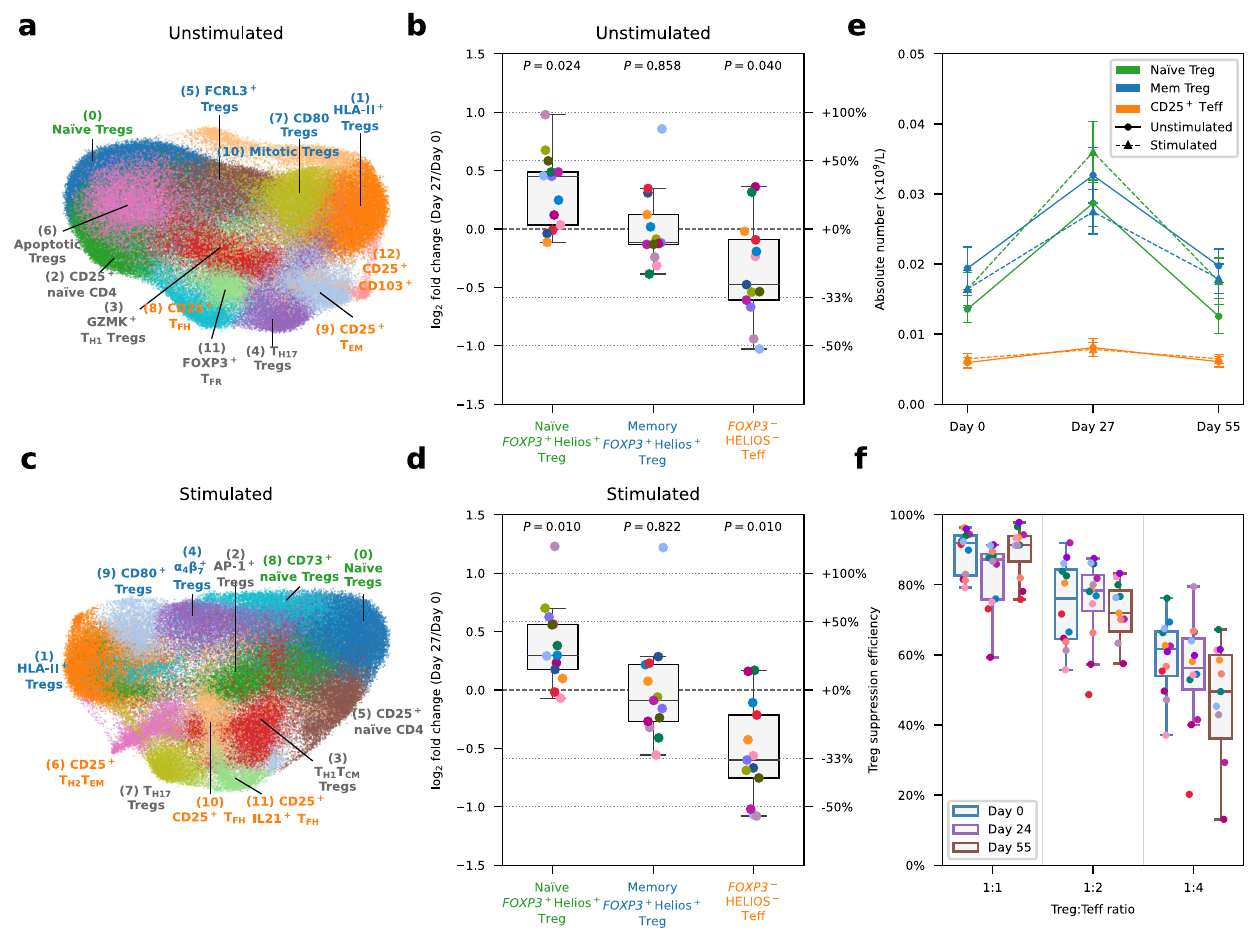
Fig. 2 | Interval low-dose IL-2 immunotherapy selectively expands FOXP3 + HE- LIOS + Tregs.a UMAPplotdepicting n =149,202unstimulatedcellssortedfromthe CD127 low CD25 hi Treg gate. Clusters were manually annotated based on the expression of key mRNA and protein markers. Clusterscorresponding to: (i) naïve Tregs (de fi ned as CD45RA + FOXP3 + HELIOS + ); (ii) memory Tregs (de fi ned as CD45RA – FOXP3 + HELIOS + ); or (iii) CD25 + FOXP3 – HELIOS – Teffs (de fi ned as CD45RA – FOXP3 – HELIOS – ) are annotated in green, blue and orange, respectively. All other clusters not conforming to this de fi nition are annotated in black. b Relative frequency changes of naïve FOXP3 + HELIOS + Treg, memory FOXP3 + HE- LIOS + Treg, and CD25 + FOXP3 – HELIOS – Teff clusters on Day 27 compared to baseline (Day 0) levels, for unstimulated cells. c , d Corresponding UMAP plot ( c ) and relative frequency of the identi fi ed subsets ( d ) for n =115,153 stimulated CD4 + T cells sortedfrom the CD127 low CD25 hi Treg gate. e Absolute cell numbersof naïve FOXP3 + HELIOS + Tregs, memory FOXP3 + HELIOS + Tregs, and CD25 + FOXP3 – HELIOS – TeffsonDay0,Day27andDay35,forunstimulatedand stimulated cells.Absolute